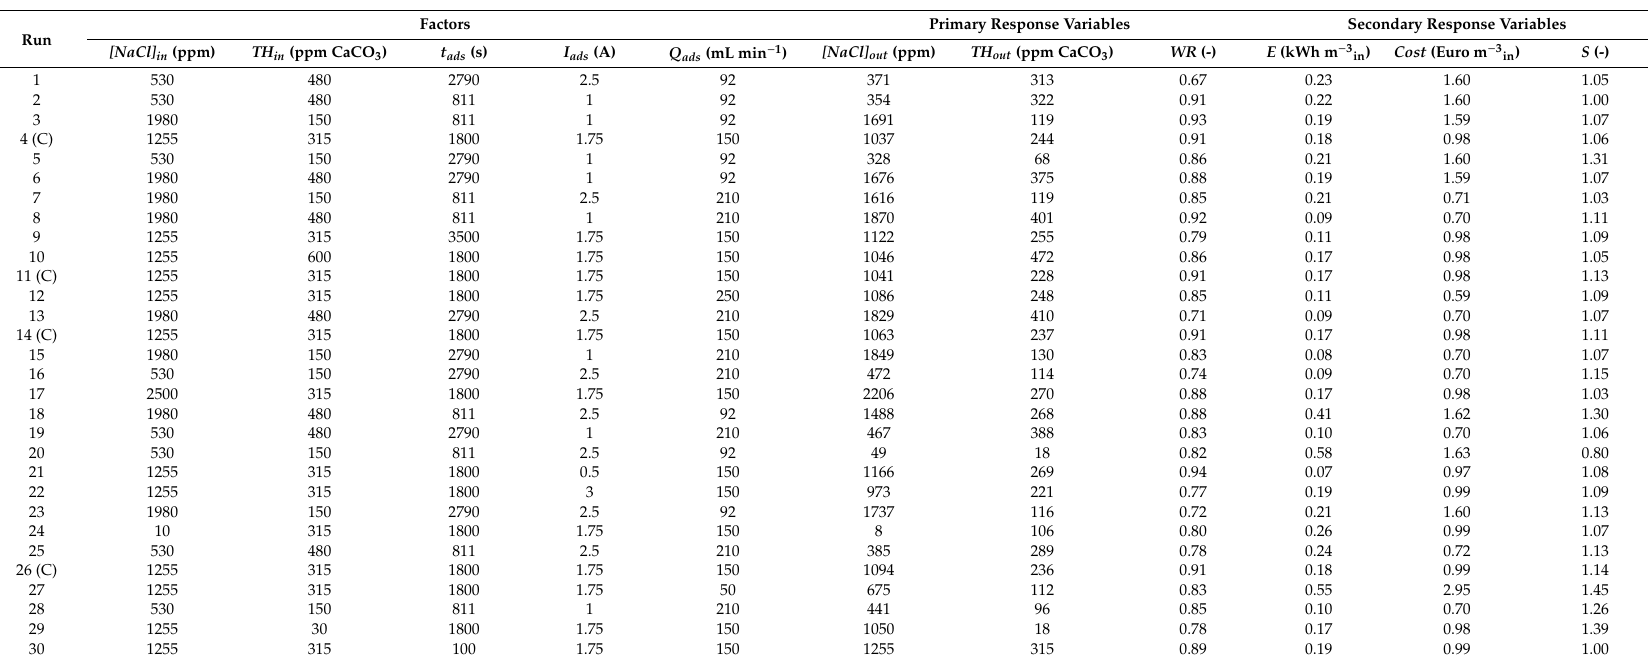
Table 2. Central composite design data. Factors (left) and response variables (right) are given for each test run. (C) indicates center point.